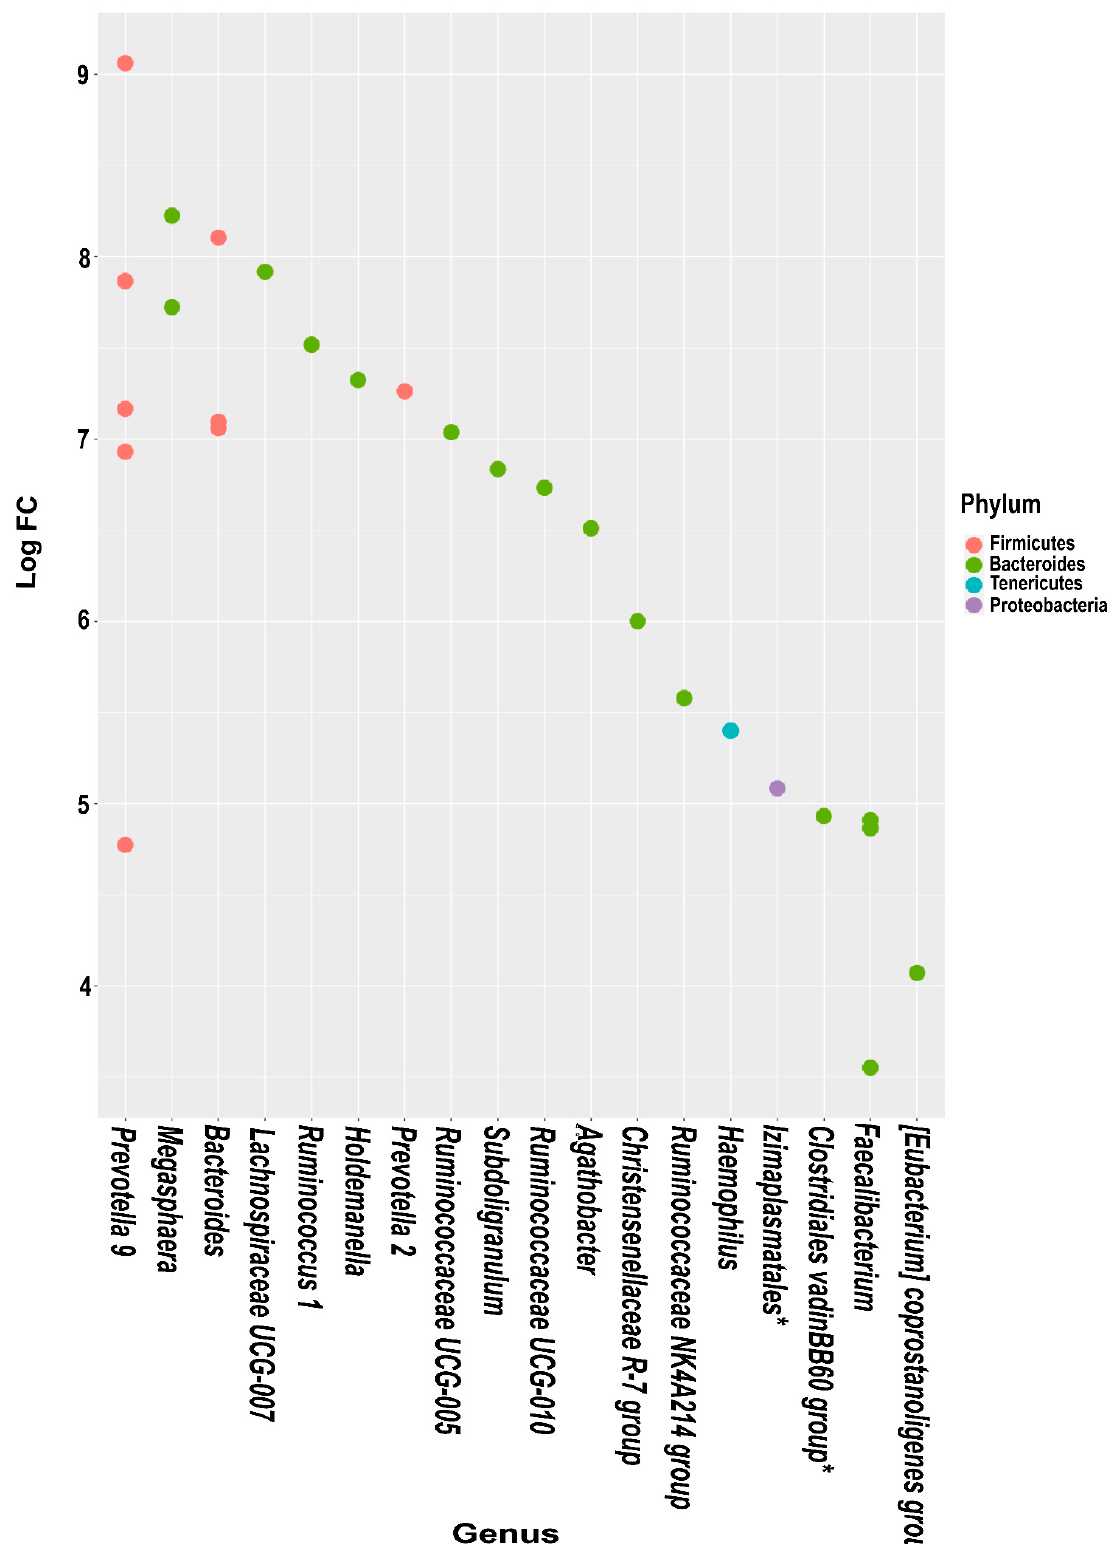
Figure 1. Log2-fold-change of the relative abundance of individual operational taxonomic units of PPARGC1A-1 compared PPARGC1A-2 genotypes at the phylum and genus level. * Identification at order or family